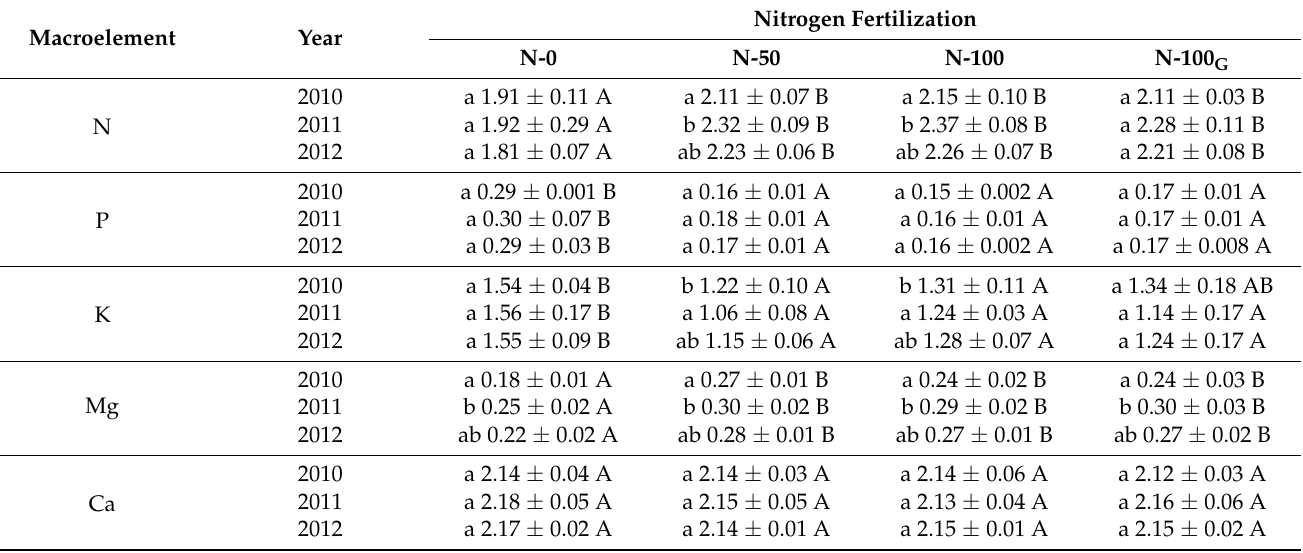
Table 3. Effect of year and nitrogen fertilization on macroelements content in apple leaves, expressed in % of dry mass (% d.m.—mean ±